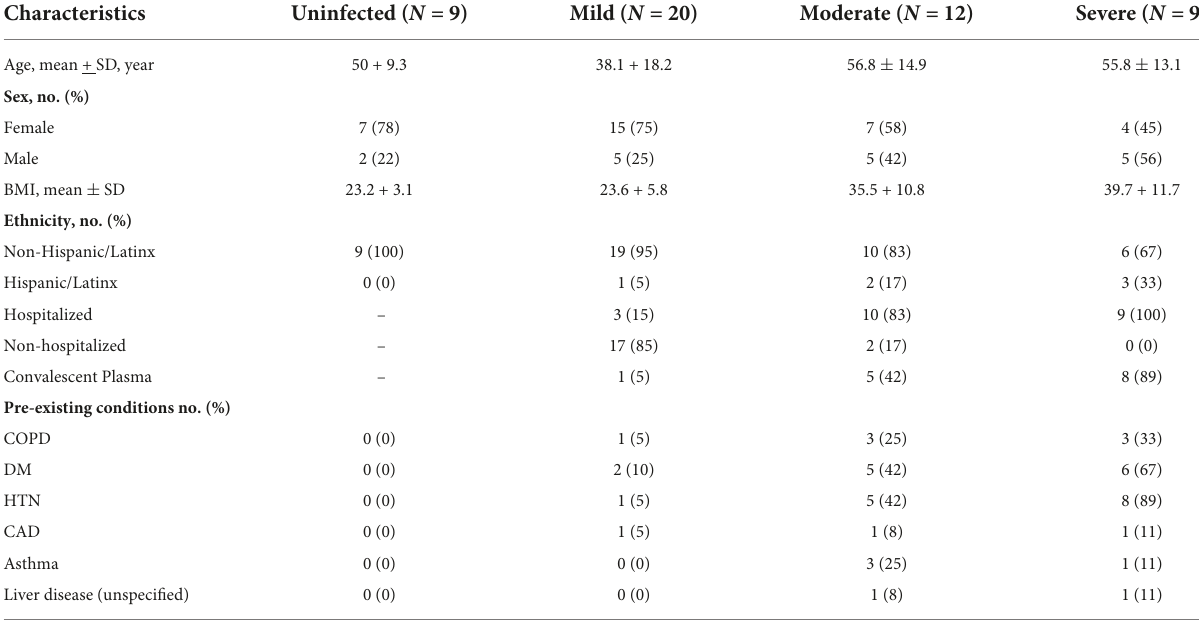
TABLE 1 Baseline adult participant characteristics by COVID-19 disease severity ( N = 50).